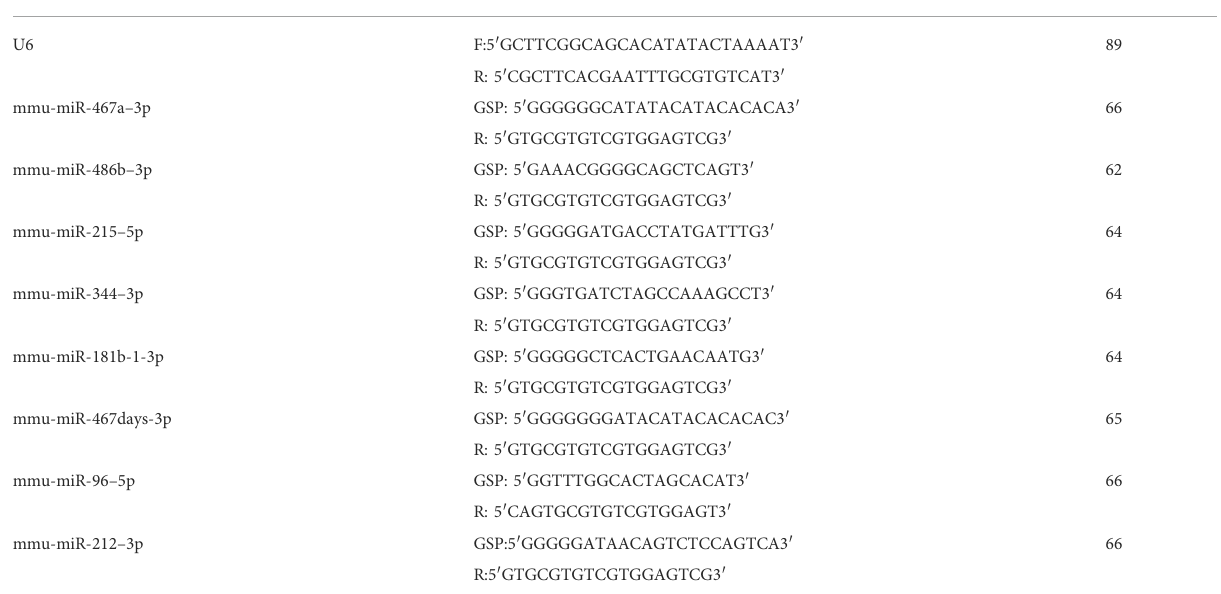
TABLE 1 Primers used for